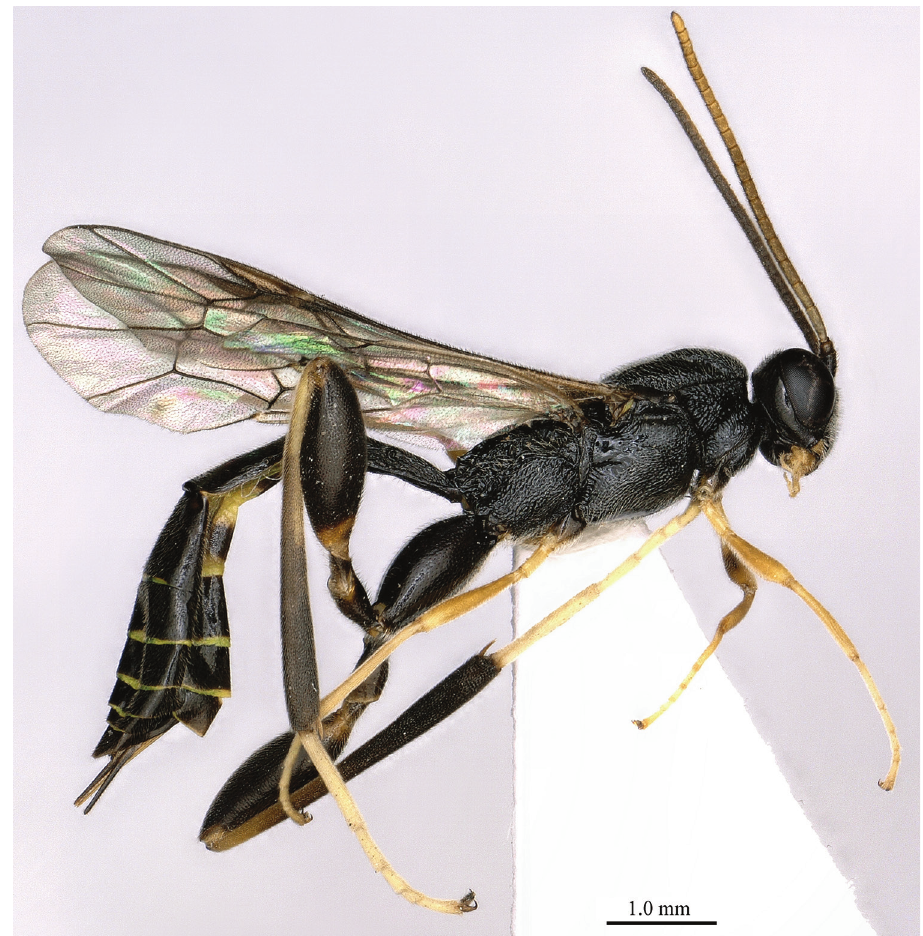
Figure 1. Bicurta hejunhuai sp. nov. (female holotype), habitus, lateral view. differentiated from these rugae. Mesoscutum (Fig. 5) with median lobe slightly con- vex in lateral view, median lobe with irregularly distributed fine punctures which are sparser centrally; punctures on lateral lobe sparser than those on median lobe; notaulus deep notaulus deep and crenulate, mesoscutum centrally with a short longi- tudinal groove behind median lobe and between meeting point of notauli; posterior median portion of mesoscutum polished, with sparse punctures. Scutellum (Fig. 5) evenly and slightly convex, sparsely punctate, distance between punctures 1.0 to 2.0× diameter of puncture. Metanotum rugose punctate. Epicnemial carina (Fig. 7) distinct ventrally and obscure dorsally, not prominent in front of median longitu- dinal suture. Mesopleuron (Figs 7, 13, 23) largely densely punctate reticulate and pubescent; dorsal anterior portion in front of subtegular ridge with short irregular longitudinal wrinkles; below subtegular ridge and in front of speculum slightly